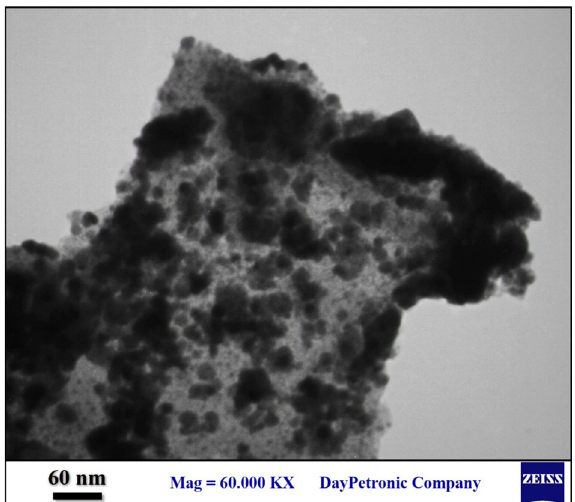
Figure 5. TEM representation of GO/Fe 3 O 4 @PDA/Au nanocatalyst.